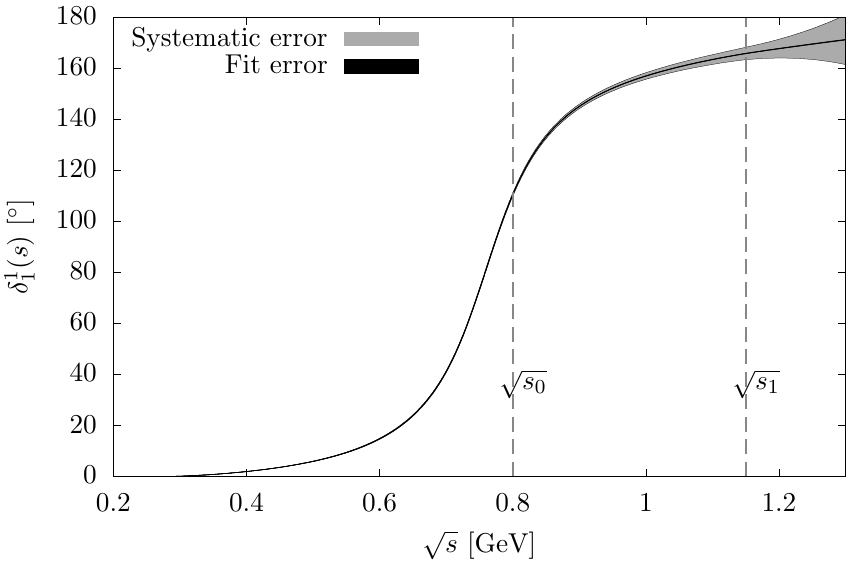
. The gray band shows 1